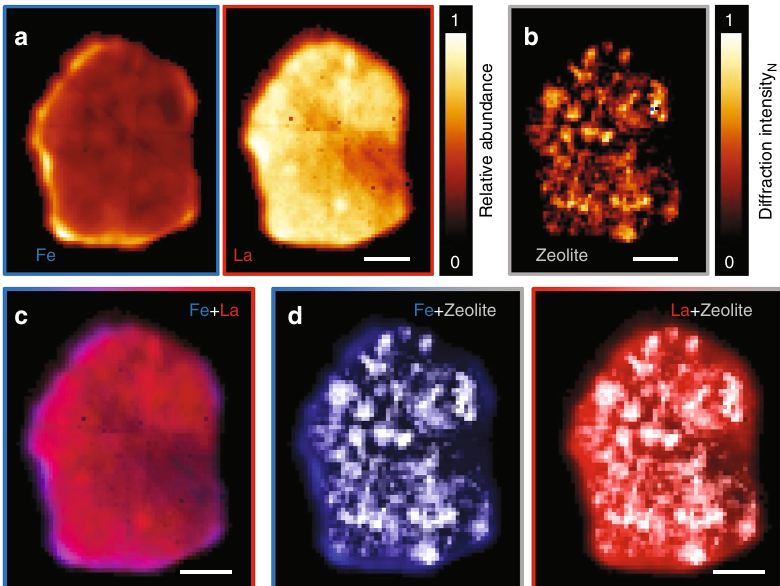
Fig. 6 X-ray diffraction tomography and tomographic X-ray fl uorescence. Presented are central orthoslices through a deactivated coked composite (FCC3). a X-ray fl uorescence maps of iron and lanthanum. b Distribution of zeolite crystals within the composite. c Additive combination of iron ( blue ) and lanthanum XRF maps ( red ) highlighting the presence of lanthanum throughout the composite including the iron-enriched shell region, supporting the initial presence of zeolites in this region. d Overlay of XRF maps and zeolite crystal distribution. The absence of crystalline zeolite within the shell region in contrast to the presence of lanthanum in this region is indicative of zeolite amorphization. Scale bars are 20 µ m. Voxel size is (1.5 µ m 3